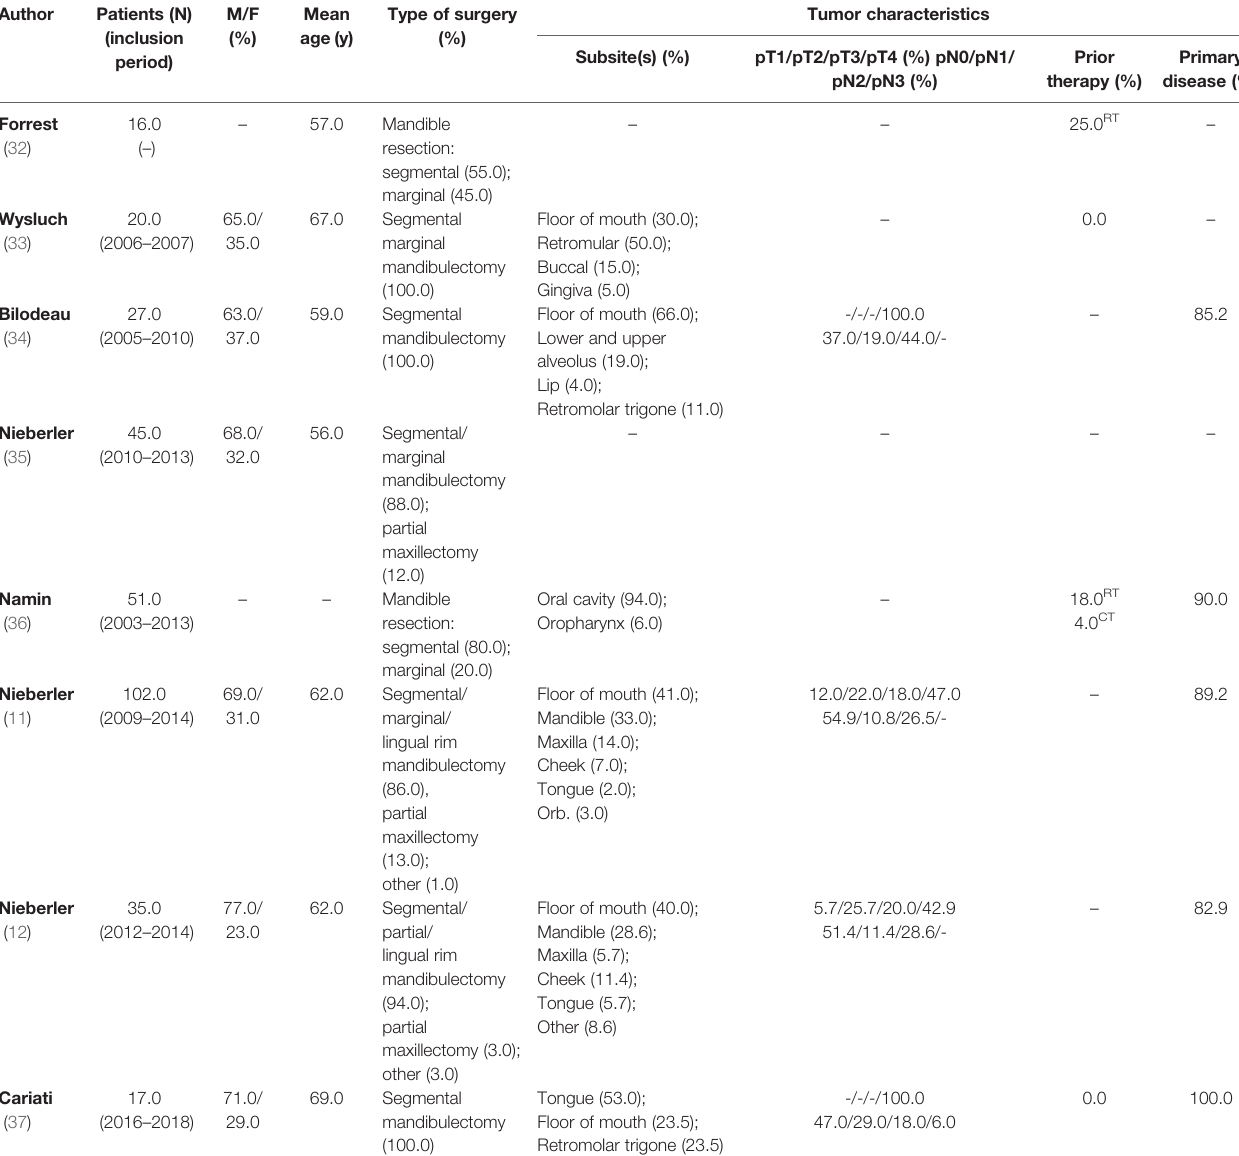
TABLE 4 | IOARM in bone tissue: patients and tumor